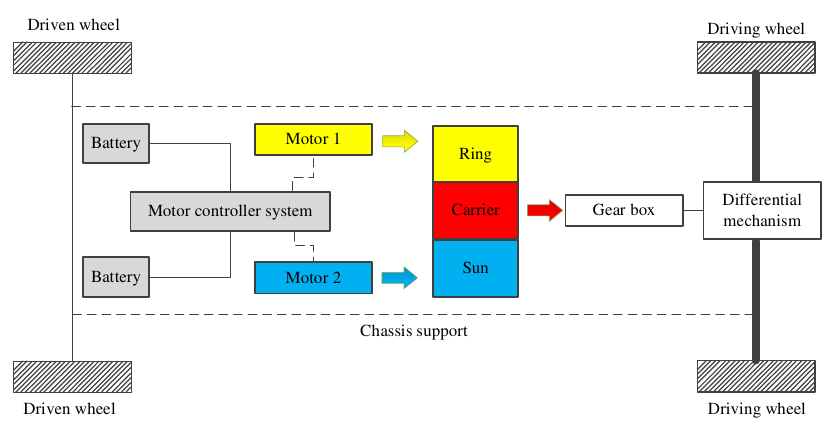
Figure 3. Structural diagram of dual motor centralized coupling drive system.